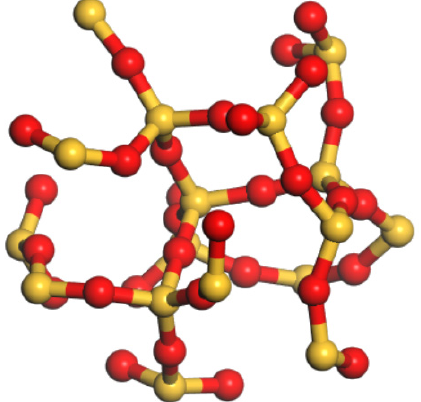
Figure 5. The amorphous nano-SiO 2 model (O atoms in red, Si atoms in orange).